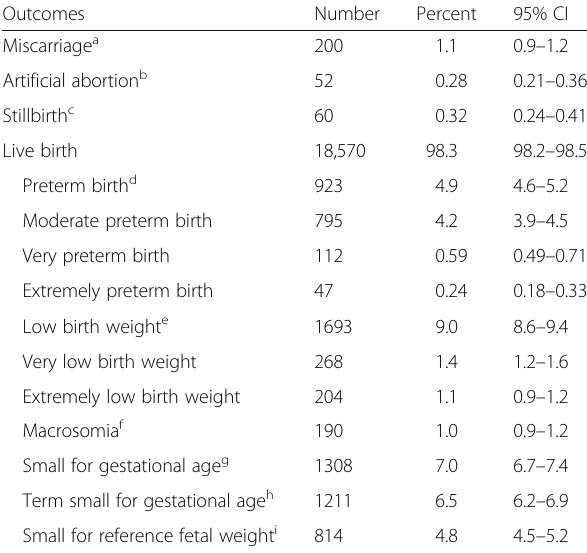
Table 5 Outcomes of singleton fetuses ( n = 18,882) at birth in the Hokkaido